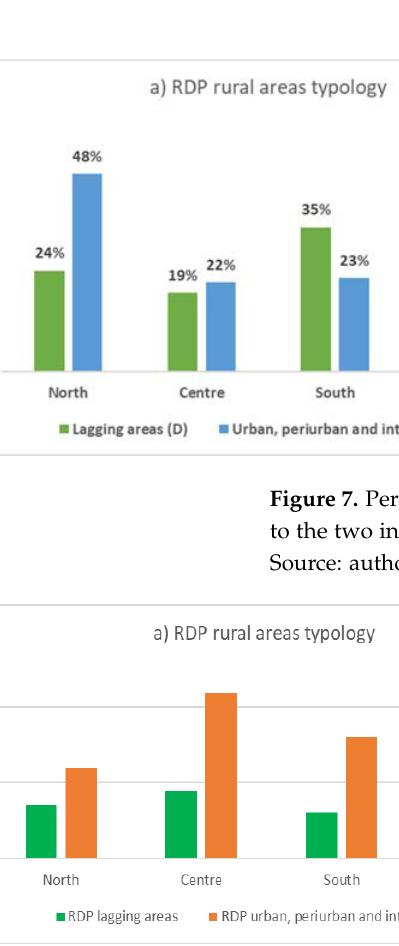
Figure 8. “Corrected” committed expenditures allocated by types of areas according to the two in- stitutional typologies. Definition ( a ): RDP rural areas; definition ( b ): IAS rural areas. Source: authors’ elaborations from the data base of funded investment projects.